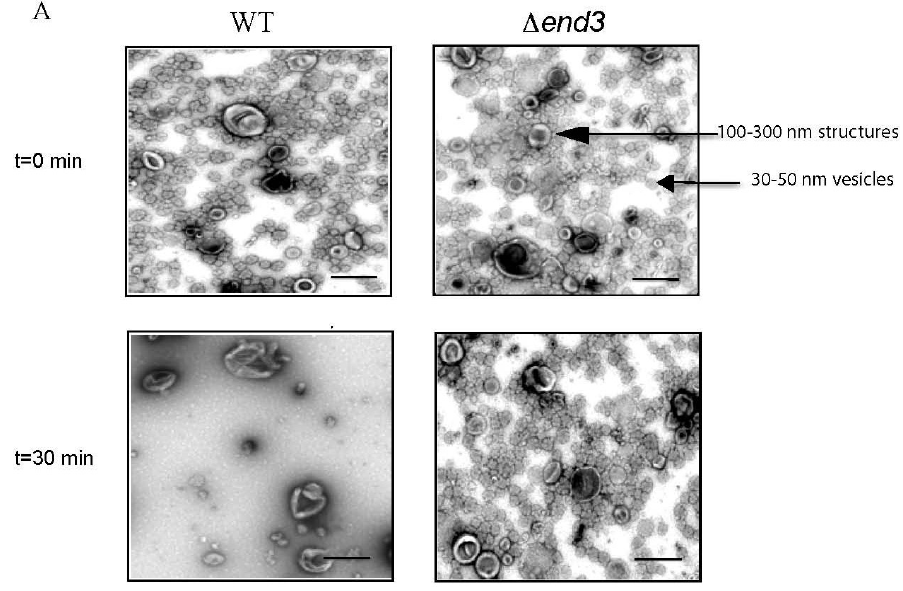
Figure 2. Glucose induces a rapid decline of small vesicles in the extracellular fraction. Wild-type and ∆end3 cells were glucose starved for 3 days and re-fed with glucose for 30 min. Total extracts were obtained and centrifuged at 3000× g and then at 200,000× g . The 200,000× g pellet fraction was fixed, stained with uranyl acetate, and visualized by TEM ( A ). Bars: 200 nm. The number of 30–50 nm small vesicles per µm 2 at t = 0 and t = 30 min in wild-type ( B ) and ∆end3 ( C ) cells was quantified. The number of 100–300 nm large structures per µm 2 at t = 0 and t = 30 min in wild-type ( D ) and ∆end3 ( E ) cells was quantified.